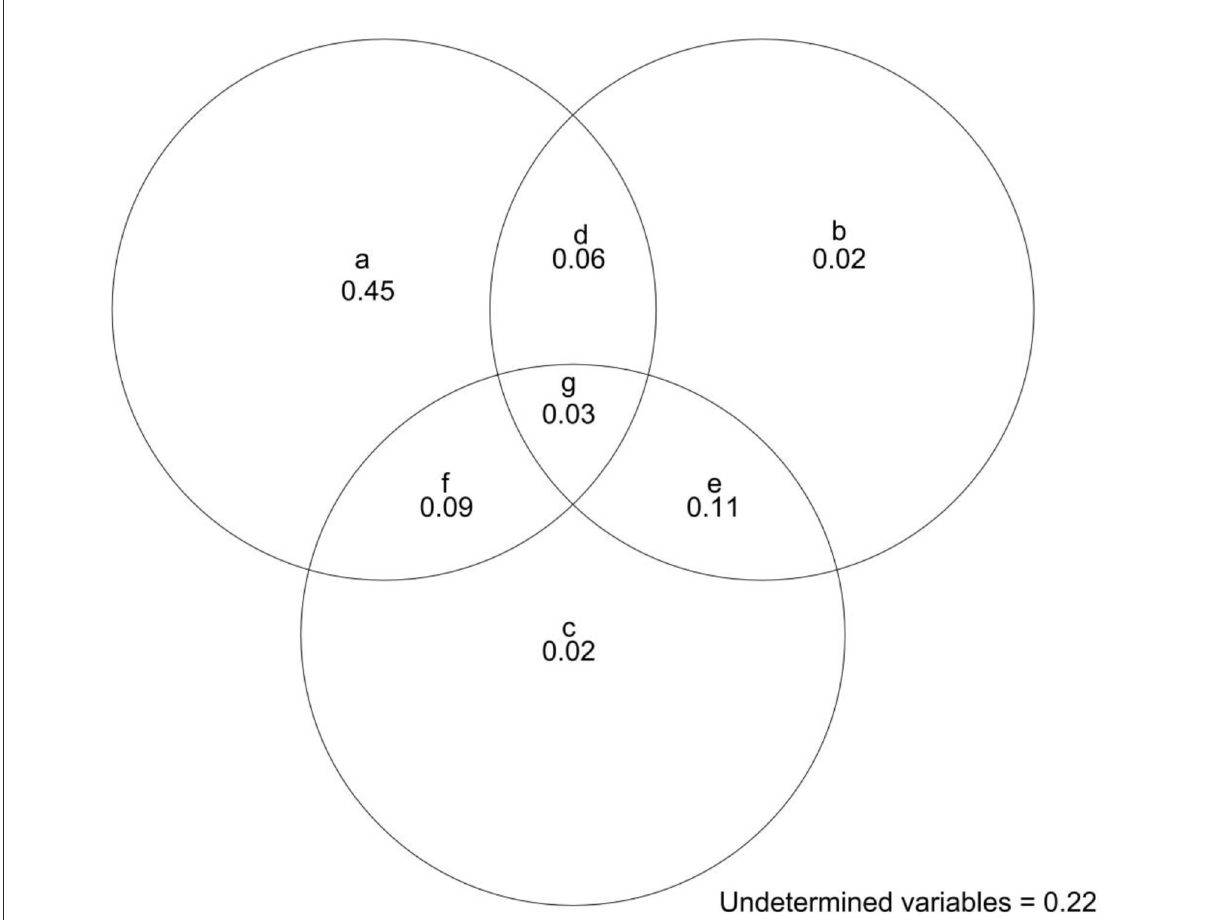
FIGURE3 The variations of beta diversity are partitioned into eight complementary components if statistically significant ( p < 0.05). Analysis was performed, including all quadrants. These eight components include (a) “purely soil variables” (explained by soil factors only), (b) “purely spatial variables” (spatial autocorrelation in beta diversity independent of soil variables and induced by dispersal limitation and biotic interactions), (c) “purely plant diversity variables (explained by plant diversity (richness and abundance) only),” (d) “spatially structured abiotic variables” (spatial autocorrelation in beta diversity and merely induced by soil variables), (e) “spatially structured plant diversity” (spatial autocorrelation in beta diversity and merely induced by plant diversity), (f) variables explained by both soil variables and plant diversity, (g) variations of beta diversity explained by soil variables, spatial variables, and plant diversity and “undetermined variables.” Variation in beta diversity of the soil nematode community explained by soil variables is represented by a + d + f + g , whereas b + d + e + g shows the variation of the soil nematode community explained by MEM. In addition, the variation of soil nematode community explained by plant diversity is reflected by c + e + f + g